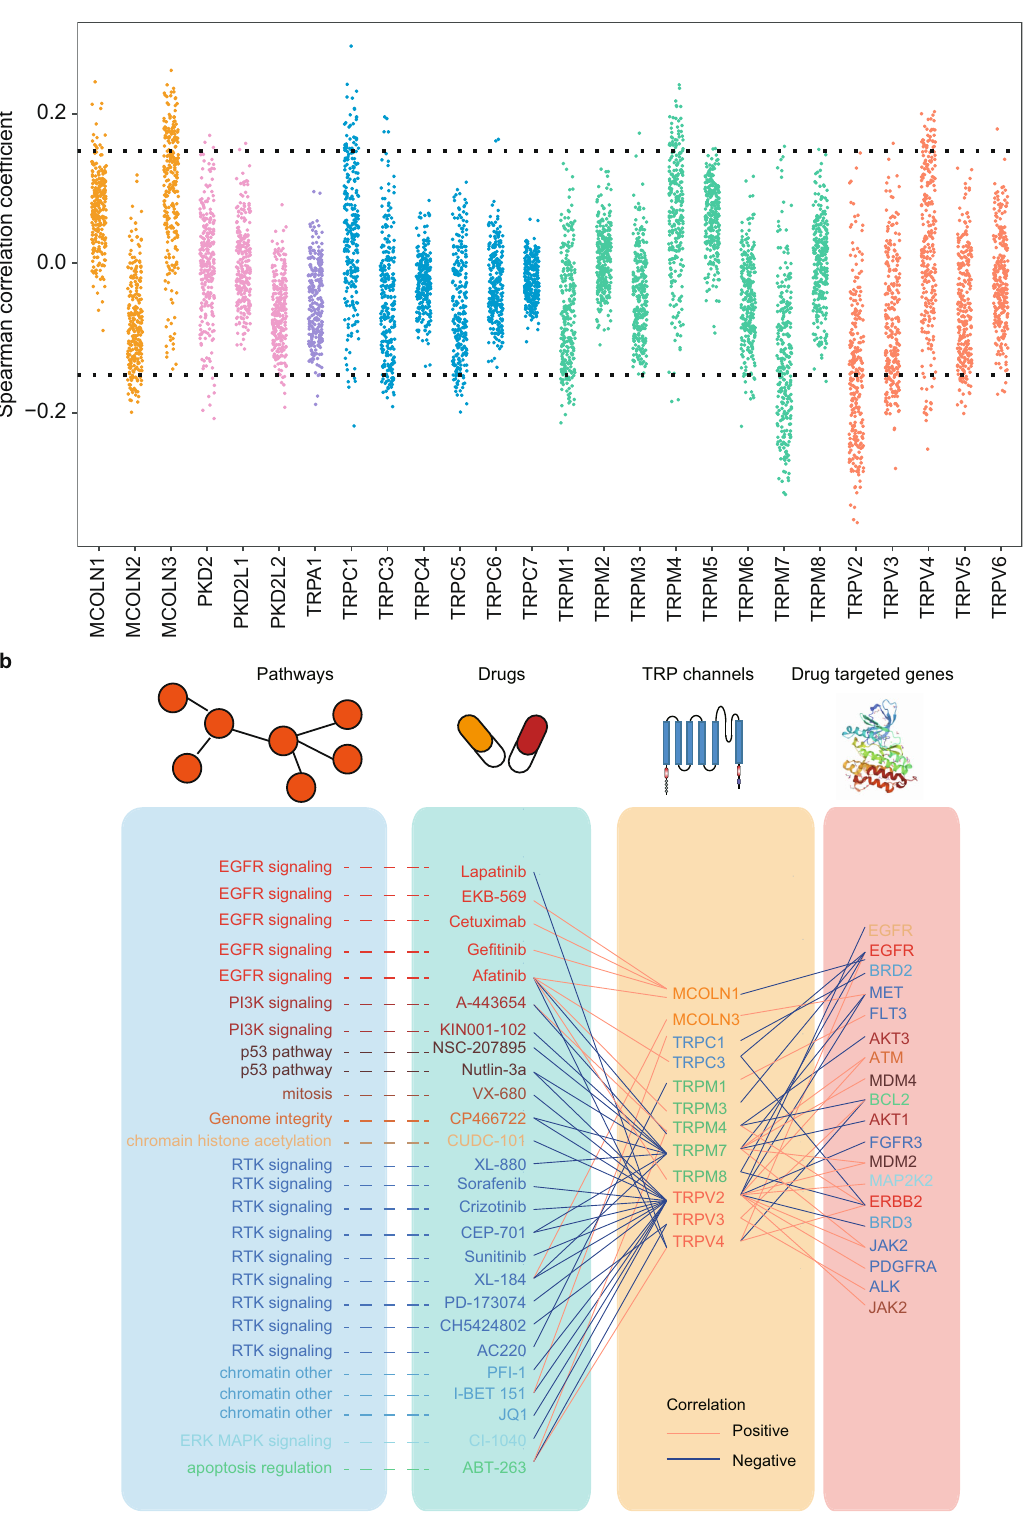
Fig. 8 Potential drug targets of TPR genes in cancer. a The Spearman correlation coef fi cients between TRP gene expressions and drug IC50. b Correlation between TRP genes and known drugs that target the genes, which involved in number of cancer signaling Somatic mutations and copy number variation of cancer atlas-hub.s3.us-east-1.amazonaws.com/download/mc3.v0.2.8.PUBLIC.xena. patients gz). Somatic mutations over 10,000 tumors across 33 different cancer types Genome-wide somatic mutations were downloaded from UCSC Xnea 41 and the ‘ MC3 ’ mutation calls fi le was downloaded (https://tcga-pancan-